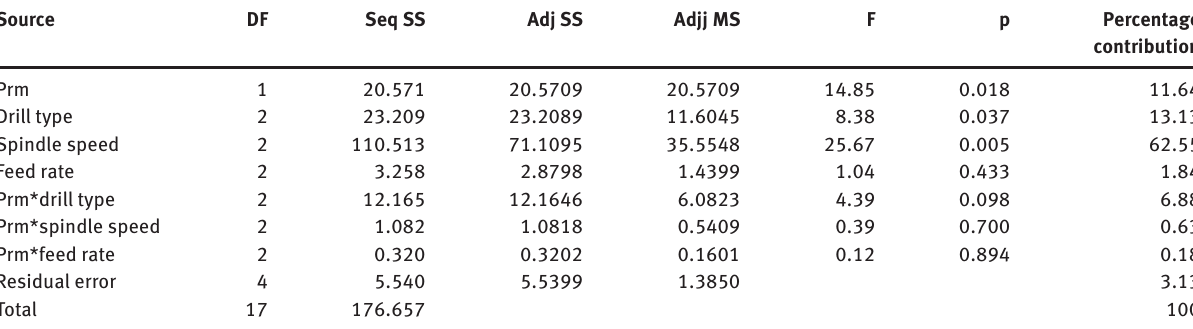
Table 9: ANOVA for S/N ratios for torque. Source